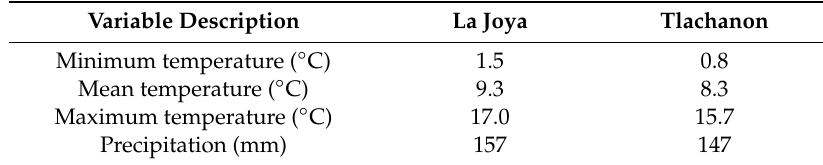
Table 6. Temperature and precipitation of the La Joya and Tlachanon sites during the monarch butterfly hibernation period (November to February).